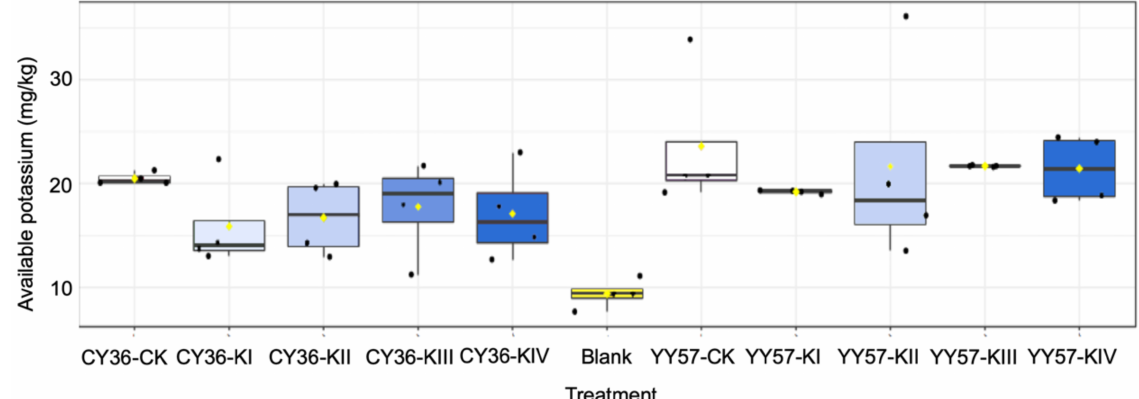
Figure 3. Effects of organic acids on AK activating in two rapeseed cultivars. Here the value of AK is the difference before and after adding the organic acid extract, KI, KII, KIII, and KIV indicate K supply level (K 2 SO 4 ) 0, 0.1, 1 and 10 mM under drought stress with 15% PEG, respectively, and CK indicate the control (without 15% PEG) 0.1 mM K 2 SO 4 . The blank is water treatment to compare with the extracts. The black dots represent the maximum, upper quartile, lower quartile, and the minimum, and yellow dots represent the median. Means and standard errors ( n = 4).